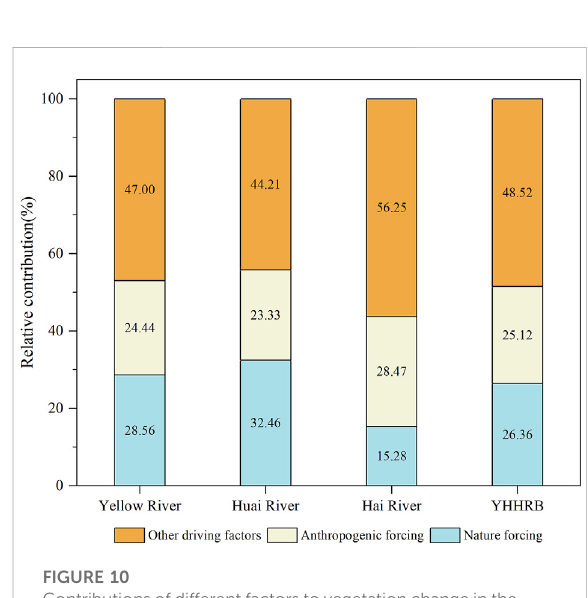
FIGURE 10 Contributions of different factors to vegetation change in the YHHRB from 1982 to